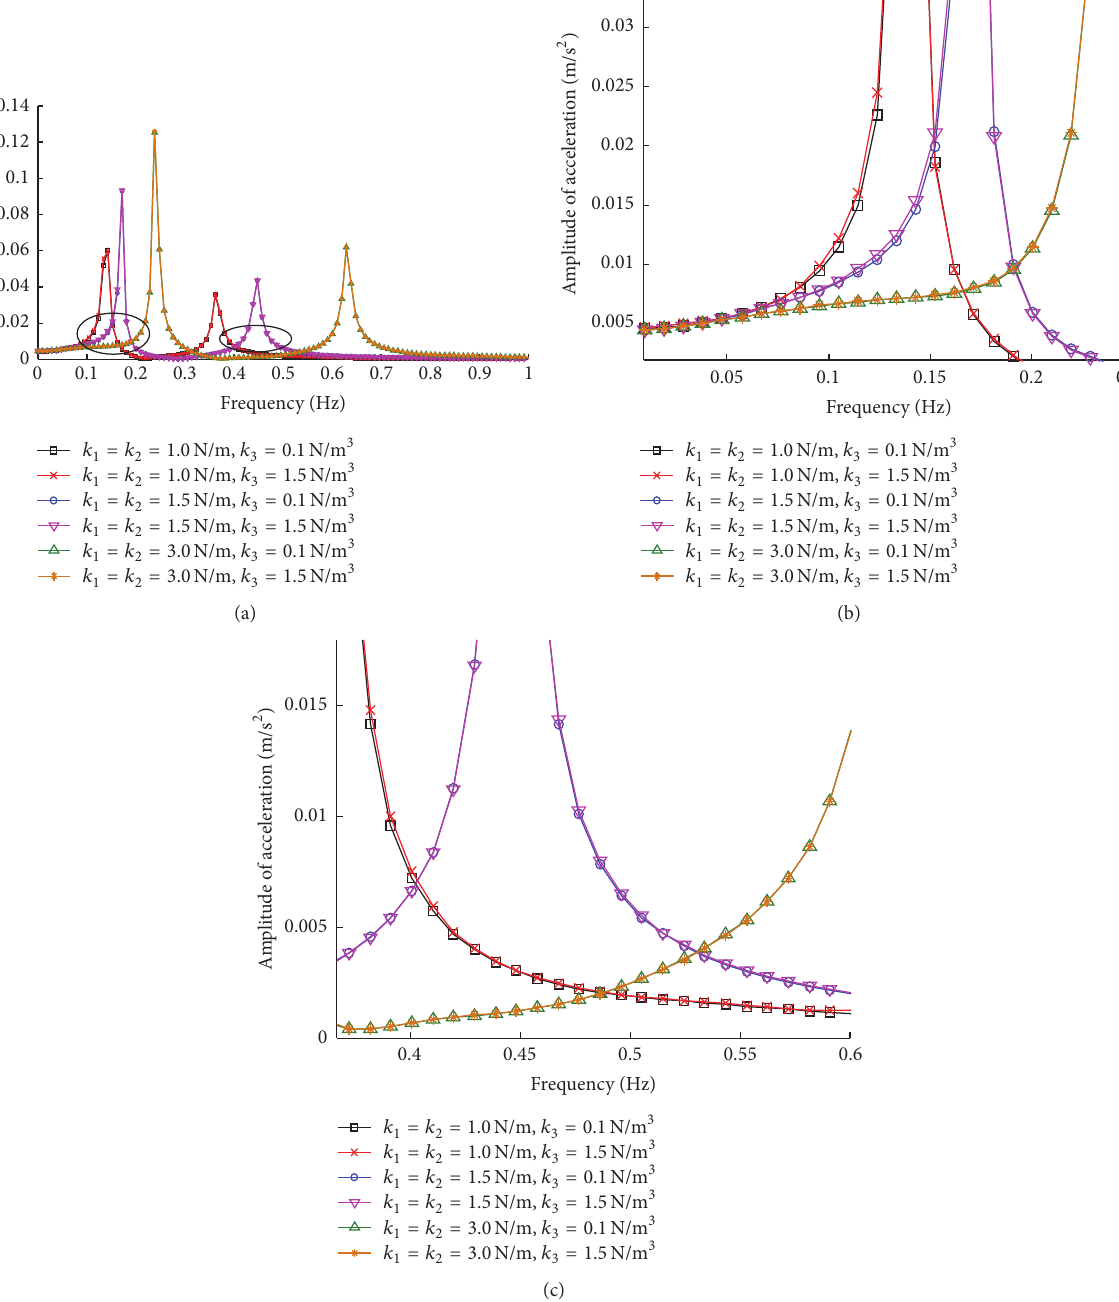
Figure 9: The comparison of frequency response curves for varying cubic stiffness when 𝑘 1 and 𝑘 2 are changed. (a) Effect of cubic stiffness term. (b) Local enlarged view from left circle. (c) Local enlarged view from right